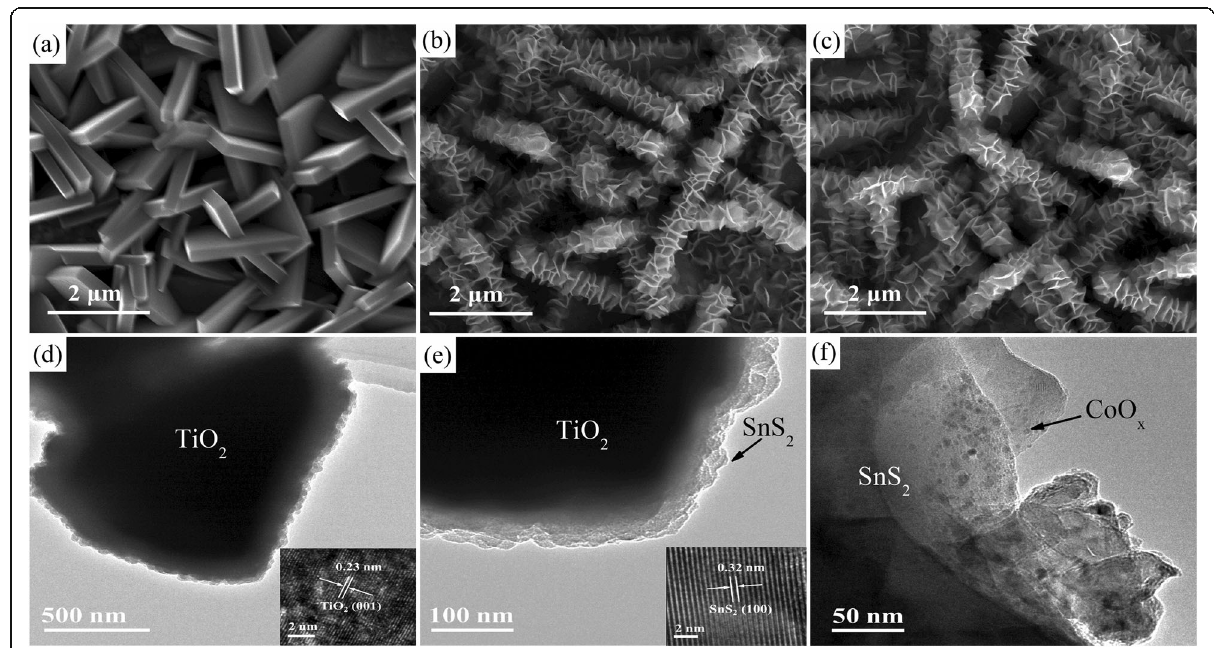
Fig. 1 SEM images of a TiO 2 nanosheet arrays, b TiO 2 /SnS 2 nanosheet arrays, and c TiO 2 /SnS 2 /CoO x nanosheet arrays. d – f TEM images of TiO 2 / SnS